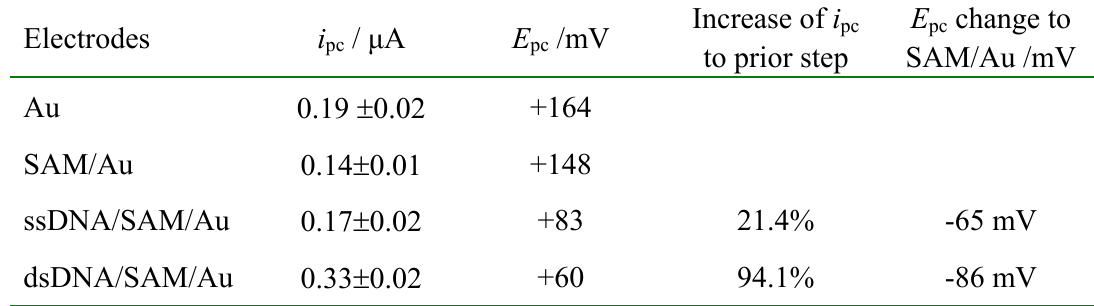
Figure 3. Cyclic voltammograms of 0.4 mM M FcPF dsDNA/SAM/Au (B) electrodes at 200 mV s -1 . Table 2. Cyclic voltammetric data of 0.4 mM FcPF dsDNA/SAM/Au electrodes at 200 mV s -1